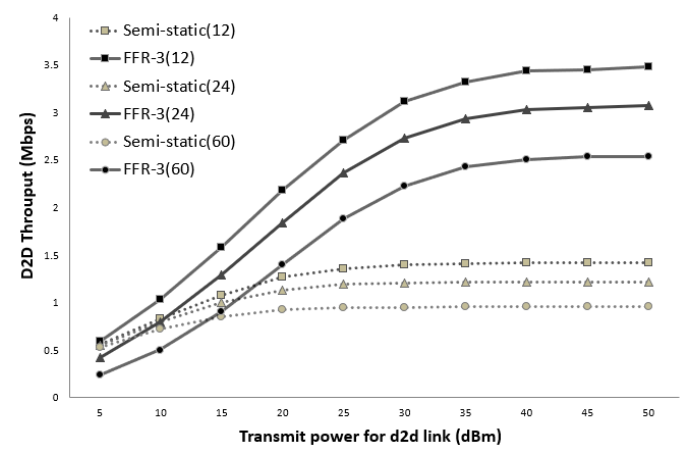
Figure 18. D2D link throughput versus D2D transmit power (cellular Tx power = 40